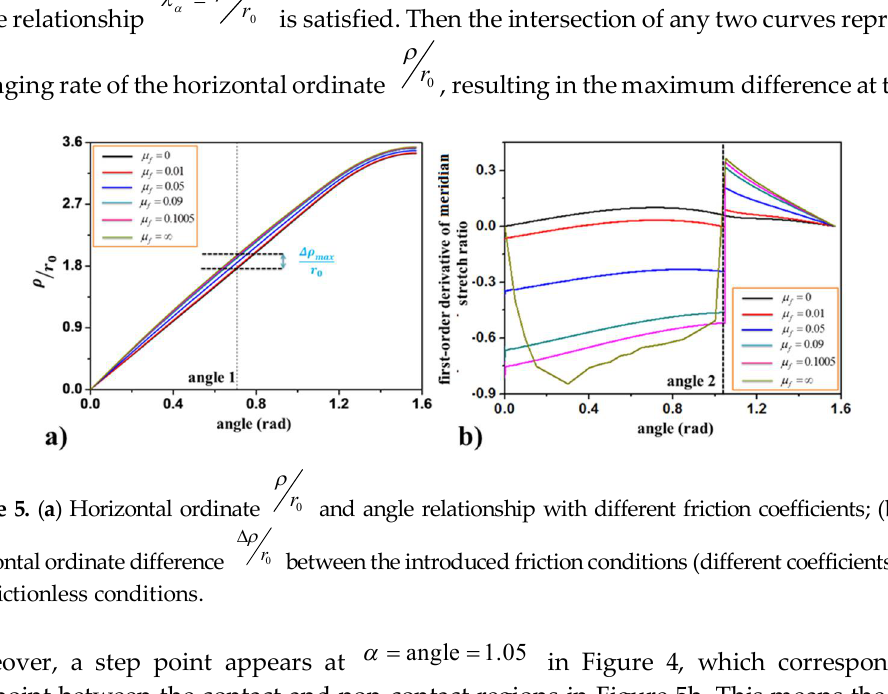
Figure 4. The changing trend of the meridian stretch ratio  friction coefficient conditions.